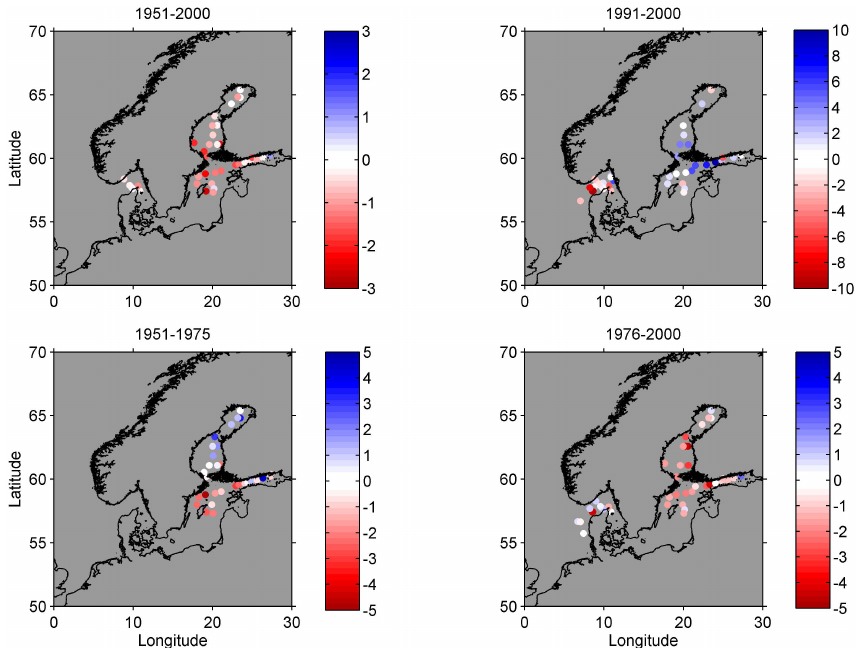
Fig. 8. Oxygen concentration trends (µmolL − 1 yr − 1 ) computed from a global oxygen database at 20m depth around northern Europe